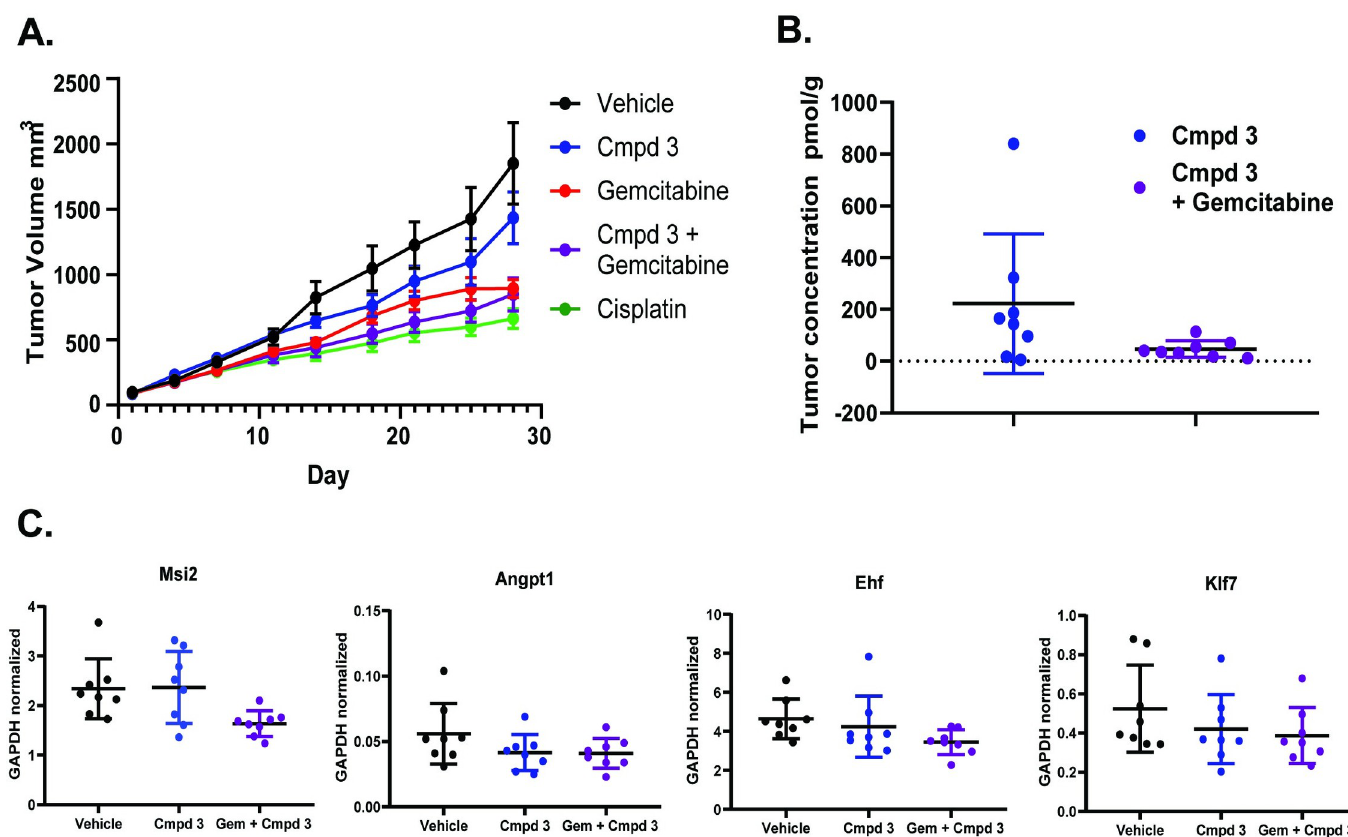
Fig 9. In vivo analysis of ROR γ t inhibitor activity on tumor growth. Tumors were implanted in the flanks of C57Bl/6 mice and treatment began when average tumor volume reached 200 mm 3 . (A) Tumor volumes from animals treated with vehicle, Compound 3 alone, gemcitabine, Compound 3 plus gemcitabine or a positive control, cisplatin, were evaluated over 28 days of dosing. Averages were calculated from n = 8 mice per group. Error bars represent SEM. (B) Concentrations were measured by HPLC and plotted as mean ± SD. (C) qPCR expression analysis normalized to β -actin expression for vehicle, Compound 3 , or Compound 3 plus gemcitabine treated tumor samples and plotted as mean ±